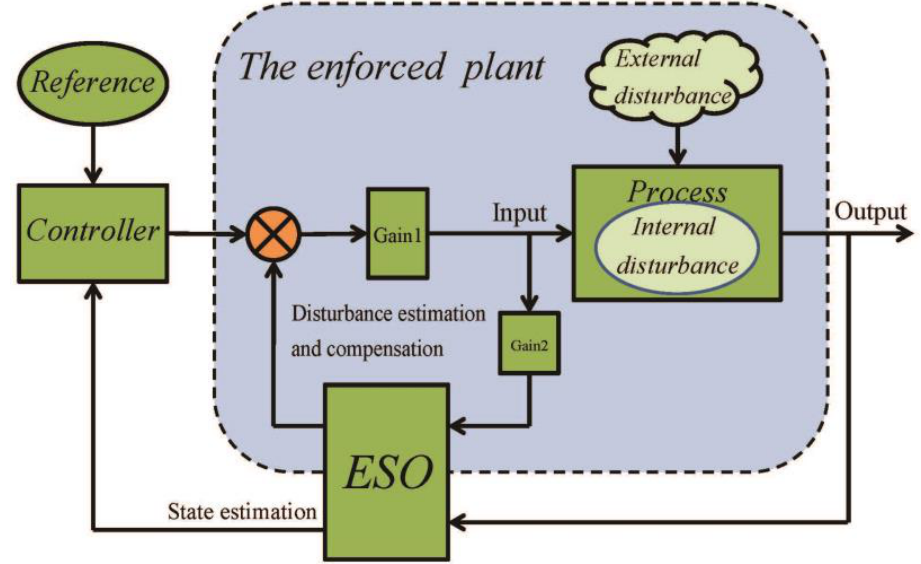
Figure 2. Schematic diagram of ADRC. According to the idea of ADRC, the flow chart of designing ADRC of smart structure is shown in the Figure